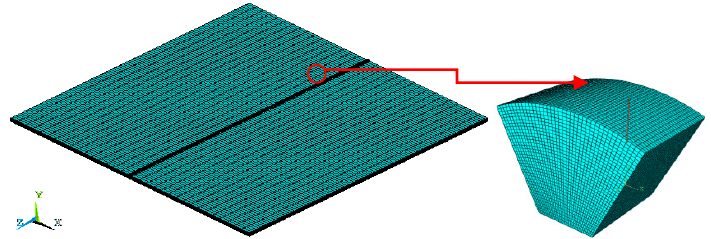
Figure 2. Submodeling method.